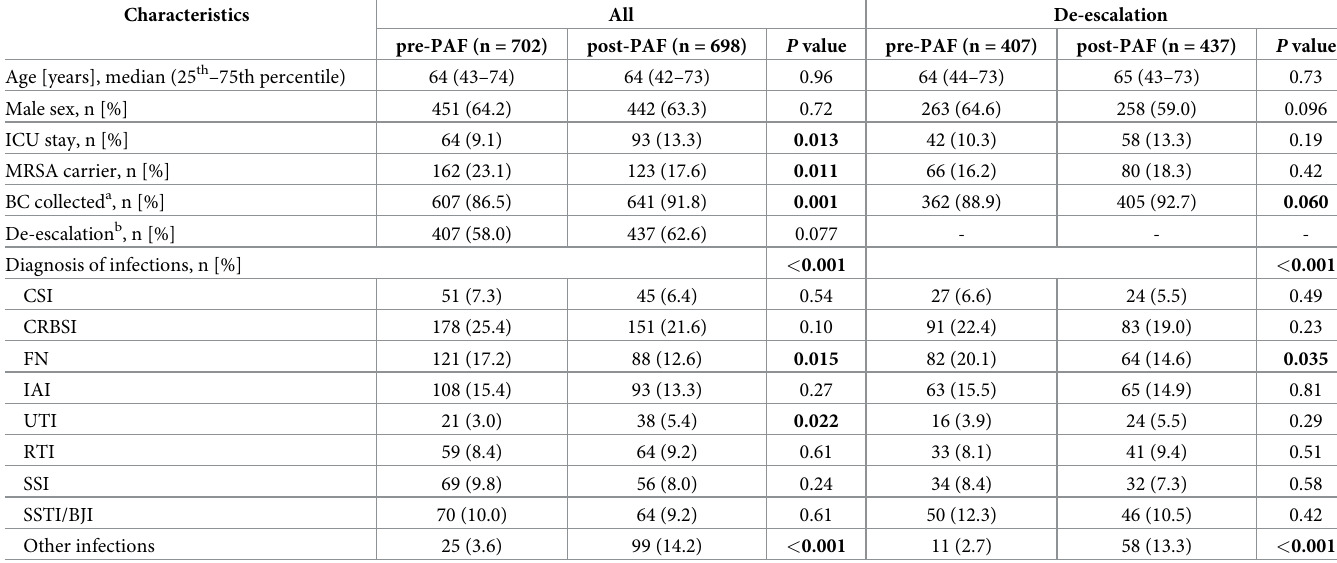
Table 1. Characteristics of the patients included in this